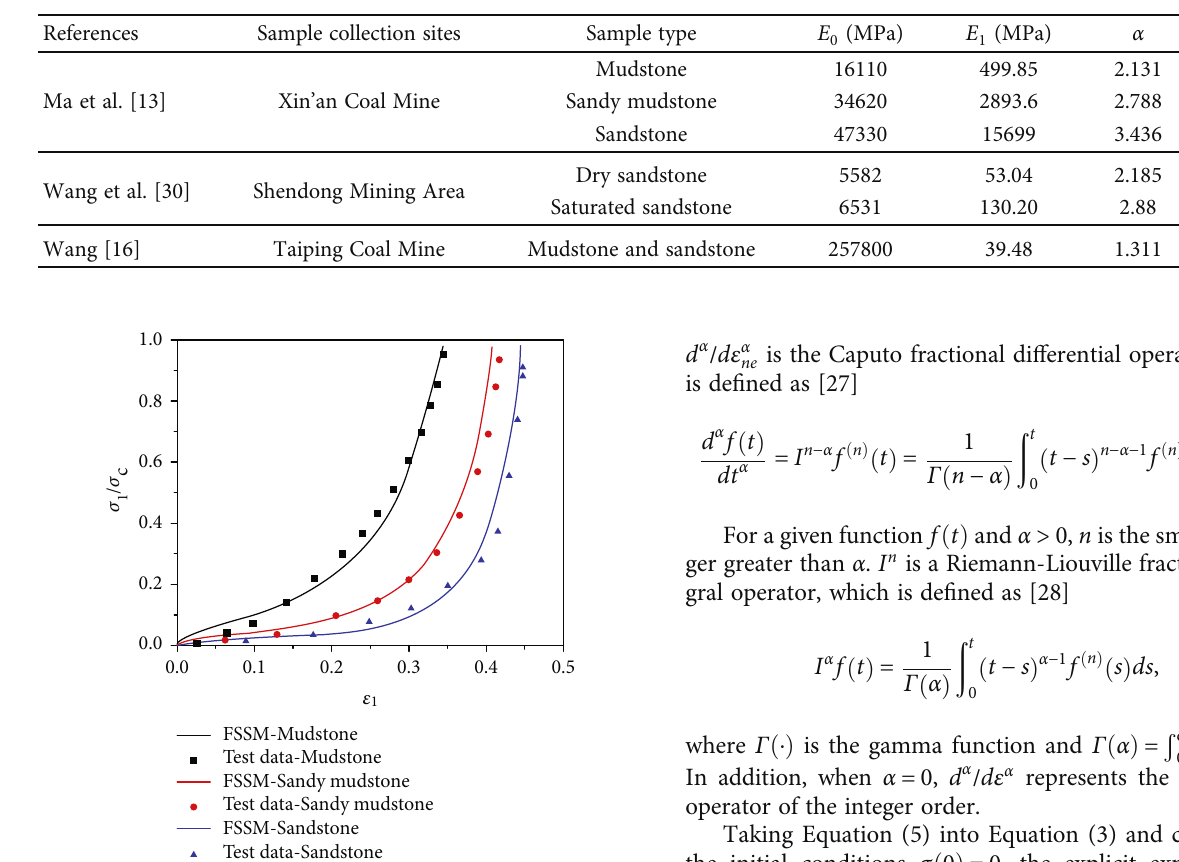
Table 1: Model parameters of water storage media.